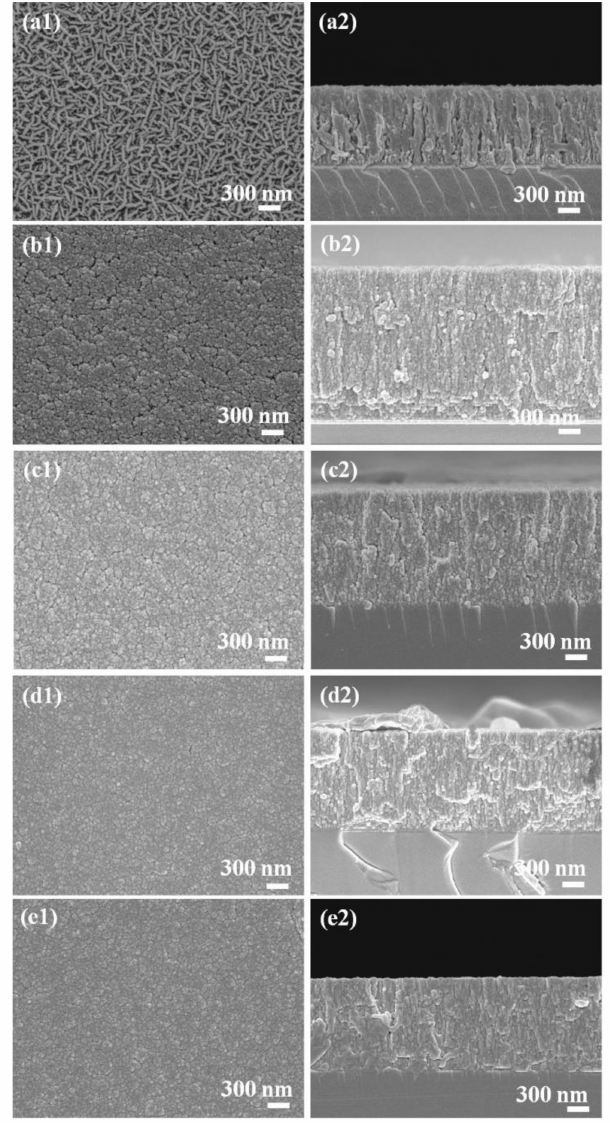
Figure 1. The top-view and cross-sectional SEM images of pure MoS 2 film and MoSN/MoS 2 multilayer films deposited with different nitrogen flow rates. ( a1 , a2 ) Pure MoS 2 film; ( b1 , b2 ) N4 film; ( c1 , c2 ) N6 film; ( d1 , d2 ) N10 film; and ( e1 , e2 ) N20